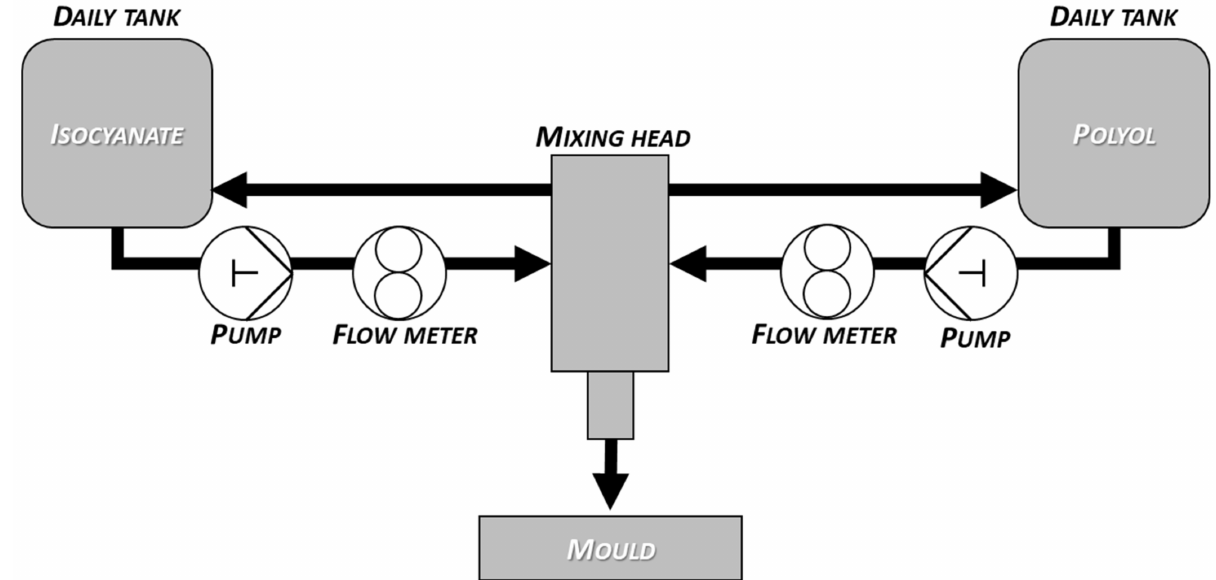
Figure 1. The simplified process flow diagram of flexible molded polyurethane foam